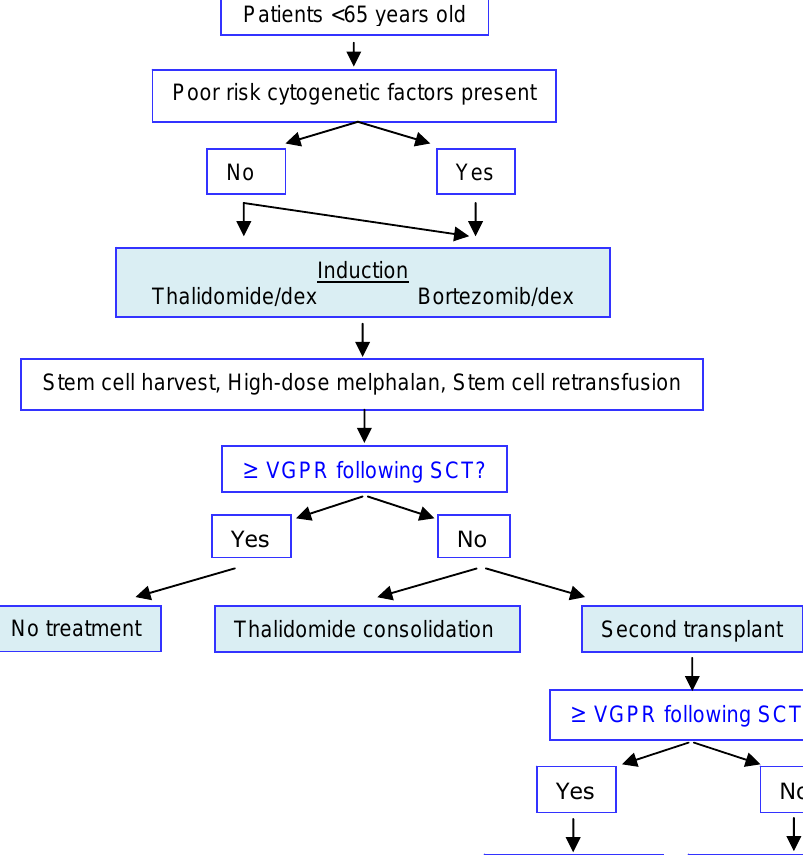
Figure 1: MM Treatment Tree – Transplant setting Figure 1a: Transplant setting – f ront-line treatment